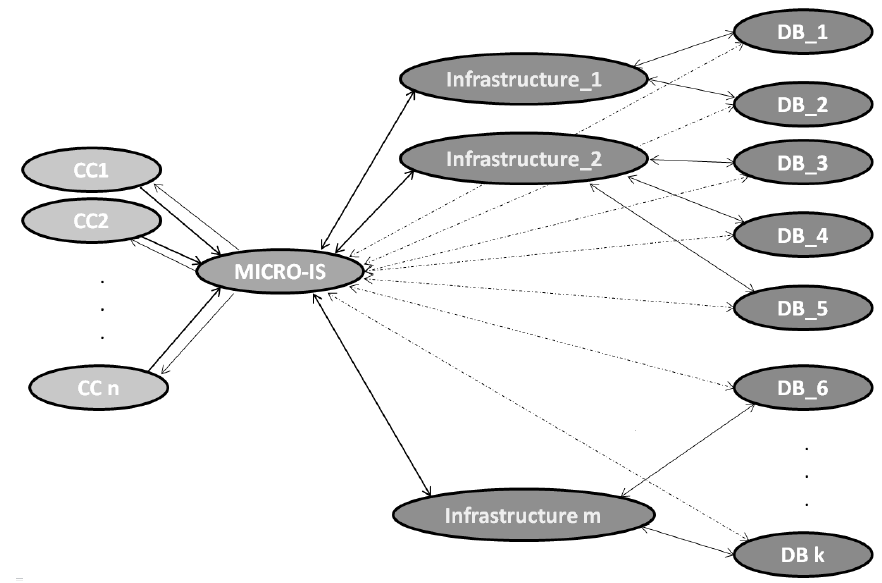
Figure 2. General integration schema.